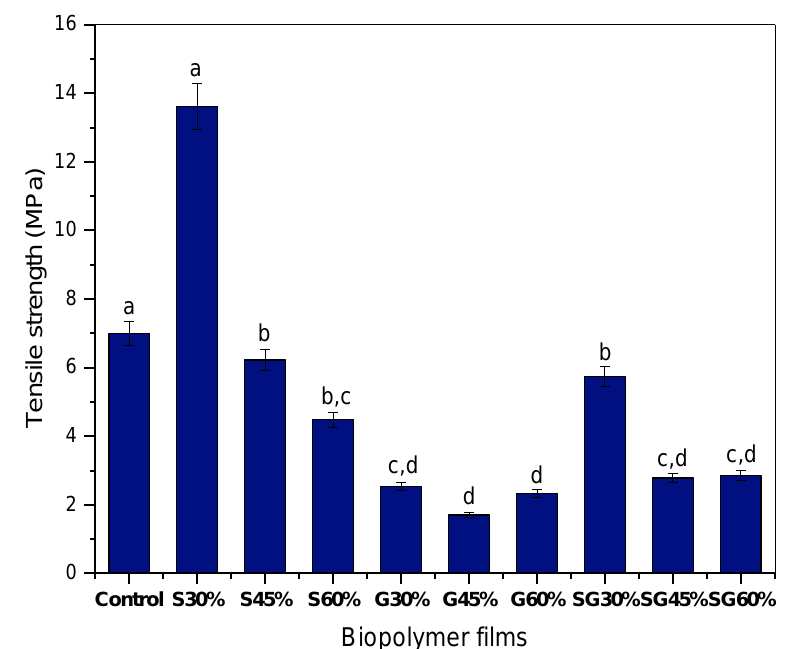
Figure 4. Tensile strength of the cornstarch-based film with different plasticizers. a,b,c Values with different letters in the figures are significantly different ( p < 0.05).